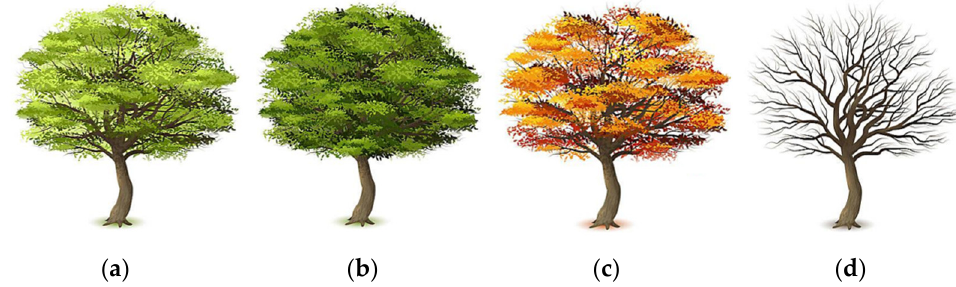
Figure 3. Representations of plants within four seasons: ( a ) spring; ( b ) summer; ( c ) fall; ( d )